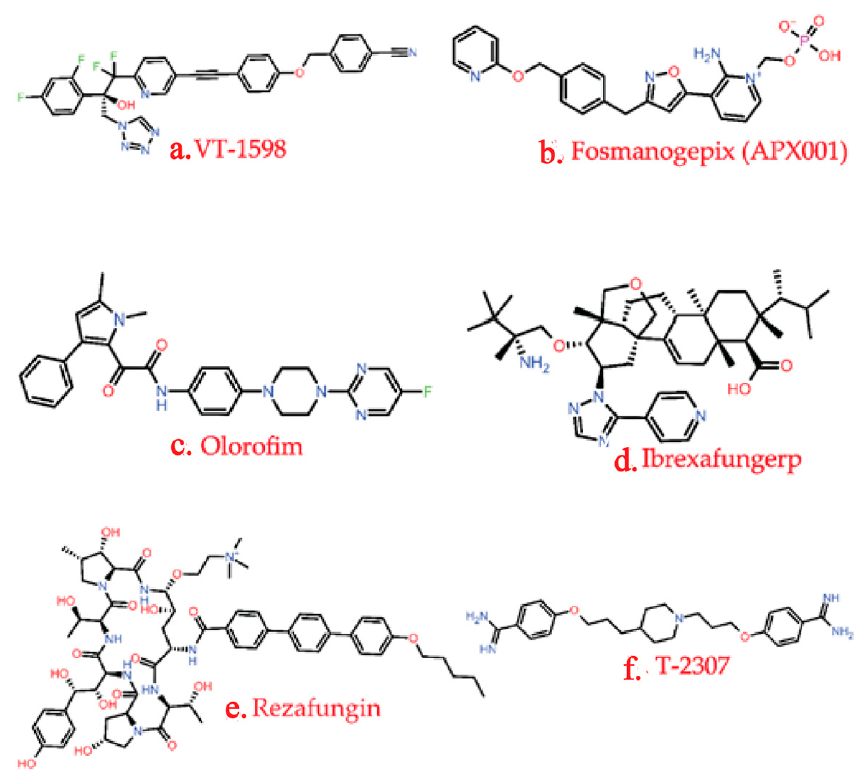
Figure 9. Two-dimensional structure of new antifungal agents developed.